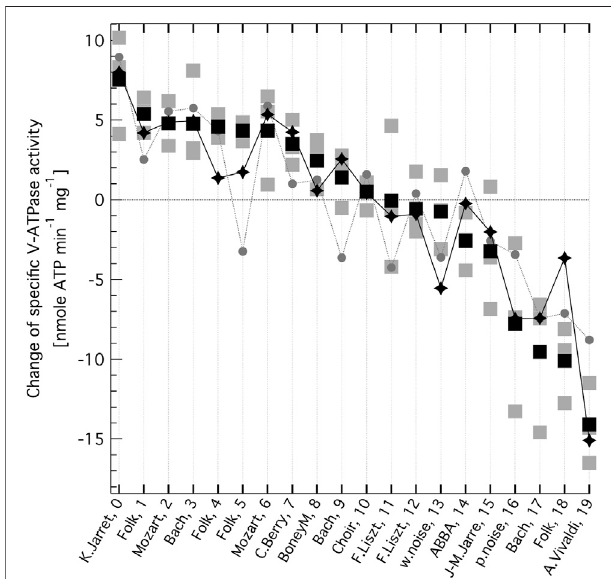
FIGURE 2 | Change in the speci fi c enzymatic activity of V-ATPase, as a consequence of exposing the enzyme to oscillating electric fi eld generated frommusic.Changesaredeterminedrelativetothecontrol,noAC fi eldvalues. The zero line corresponds to the mean control (no AC- fi eld) V-ATPase activity of 45.2 nmole ATP min − 1 mg − 1 . The music sources from various genres and their audio fi le indexes are indicated on the x axis (see Supplementary Table S1 for more details). Grey squares are independent experiments, black squares are their mean values (All optical density ( OD ) and speci fi c activity ( SA ) data are given in Supplementary Table S2 ) The summed intensity of the base frequency at 141.9 Hz and its fi rst 4 overtones (grey circles) and that of 6 selected bands from an iterative search (black diamonds, see text) of the Fast Fourier Transform (FFT) spectra of the normalised music audio clips are also shown after best fi tting linear scaling.